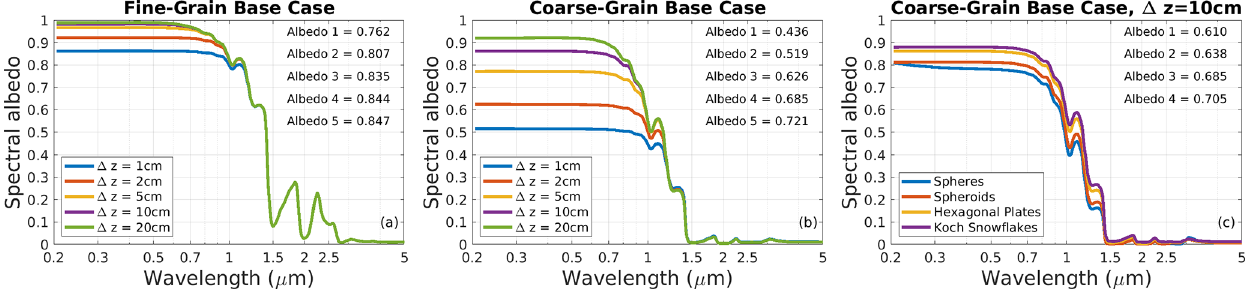
Figure 5. Albedo variations of thin, impurity-free snow in SNICAR-ADv3. Spectral albedos are shown for varying snowpack thickness in the fine-grain (a) and coarse-grain (b) base cases, and for different ice grain shapes with a fixed snowpack thickness (c) . The order of broadband albedos shown in each panel corresponds with the legend order.